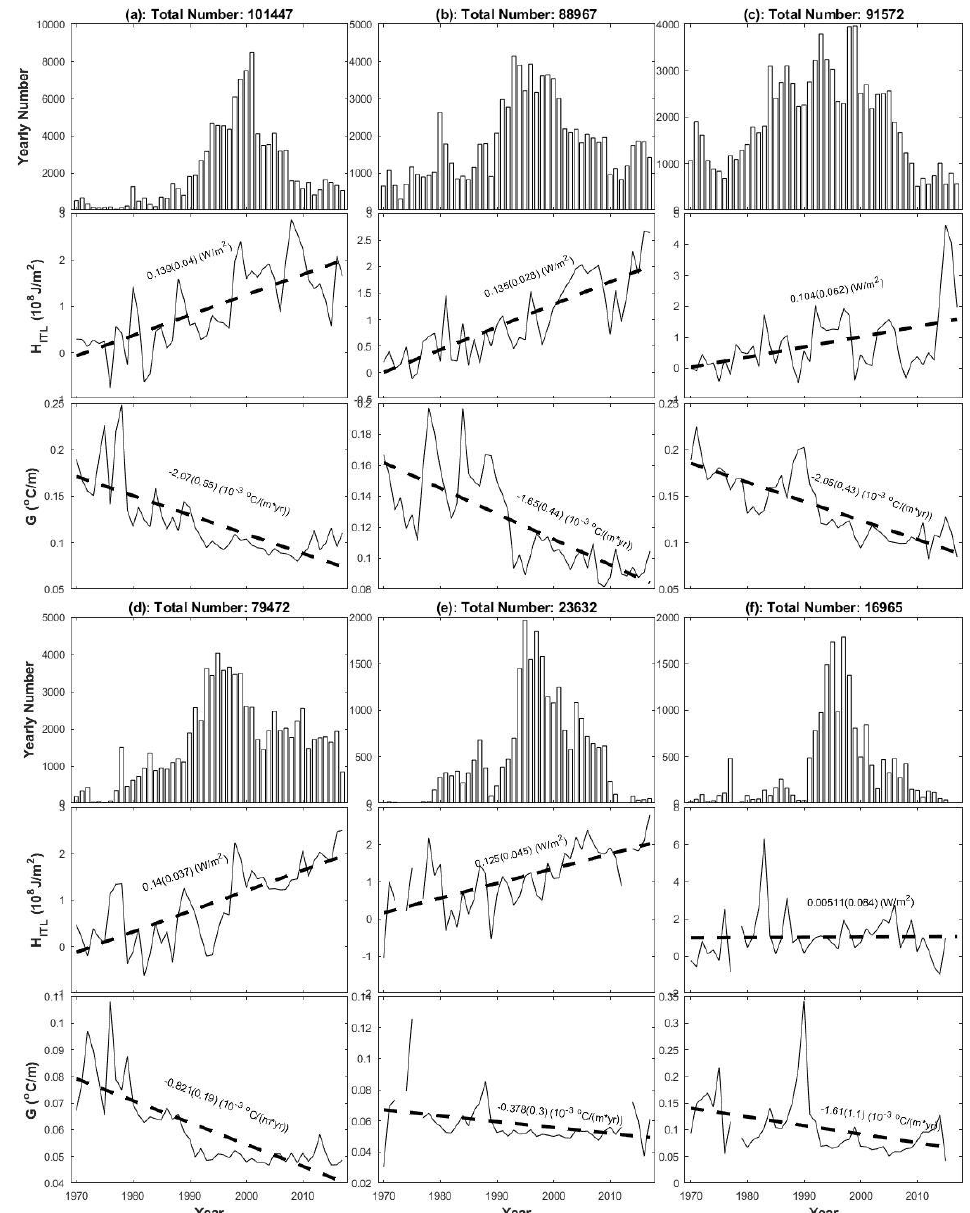
◦ N–60 ◦ N, 120 ◦ E–160